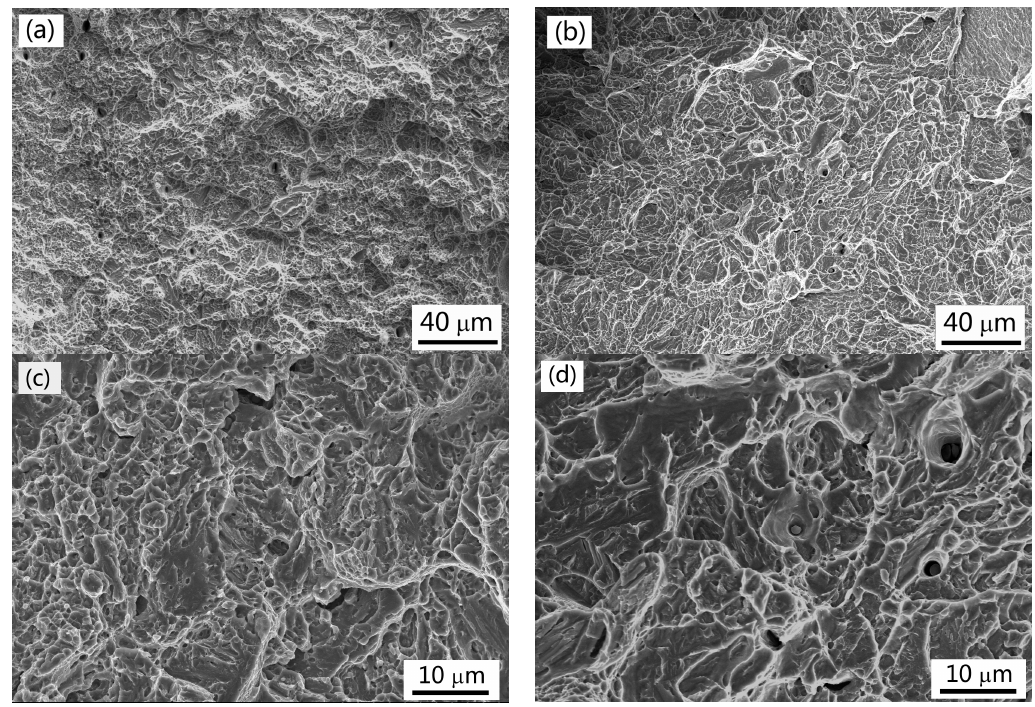
Figure 7. SEM fractographs of impact samples isothermally transformed at 260 °C after austenitised at ( a , c ) 900 °C and ( b , d ) 1150 °C. ( a , b ) are low magnification images; ( c , d ) are high magnification images.